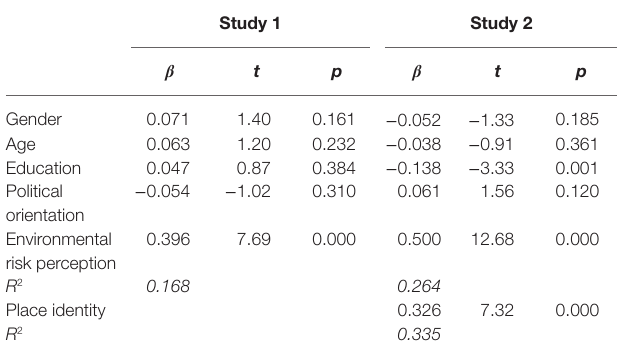
TABLE 2 | Predictors of participants’ agreement with the policy proposal (Studies 1 and